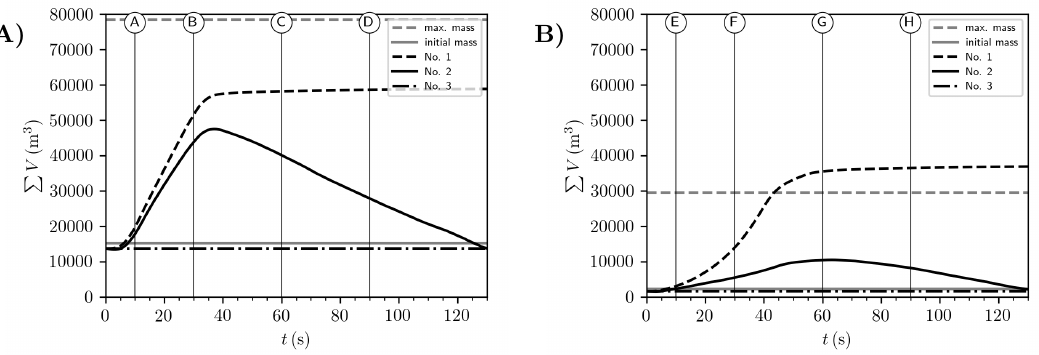
Figure 7. The sum of the mobilized volume in the simulation for ( A ) avalanche #0017 and ( B ) avalanche #0019 for the three simulation setups no. 1, no. 2 and no. 3. The vertical markers A–D and E–H correspond to the snapshots of the simulations in Figure 6 and the markers in the MTI images (Figures 4 and 5). Gray horizontal lines give volumes of initial release (lower line) and total volume (upper line), reported by Köhler et al.